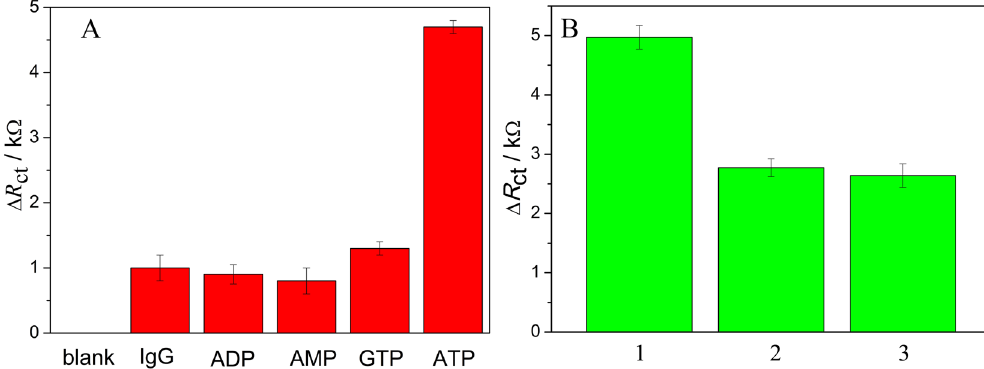
Figure 5. ( A ) The Δ R ct value responses to 10 − 5 mol·L − 1 ATP and the interferents (ATP, IgG, ADP, AMP, GTP) based on Ce-MOF-apt; ( B ) the Δ R ct value responses to 10 − 5 mol·L − 1 ATP for different cycles. (In the